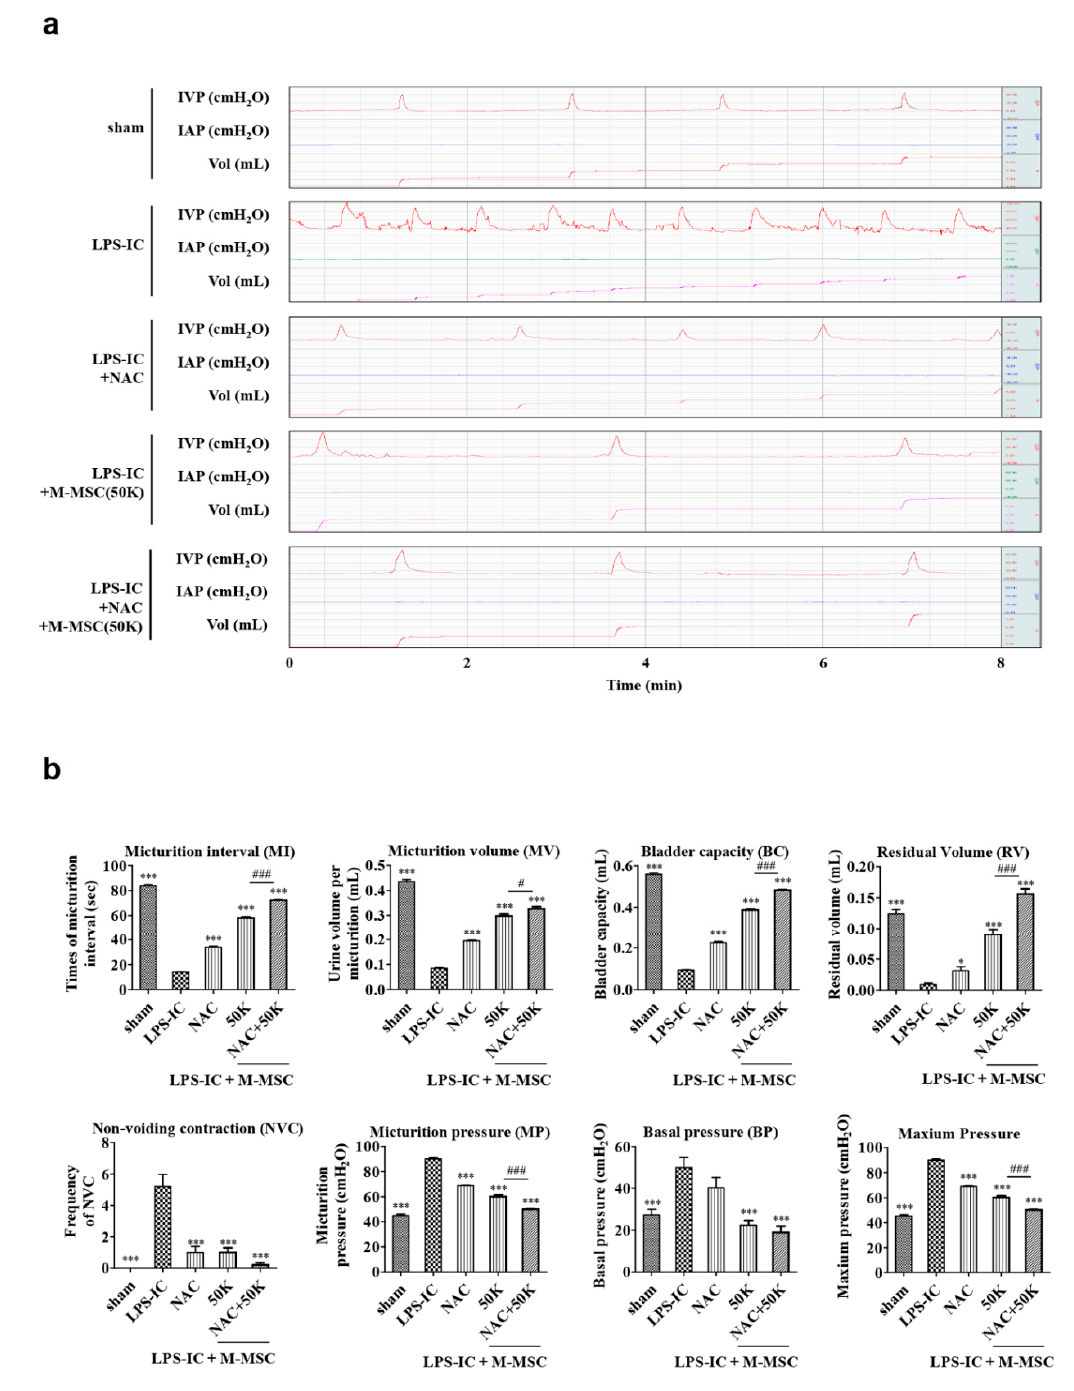
Figure 2. N-acetylcysteine (NAC) and 50K M-MSCs injection ameliorated the bladder voiding function in a LPS-IC rat. ( a ) Awake cystometry. ( b ) Representative awake cystometry results and quantitative bladder voiding parameters at one week after NAC and M-MSCs (50K, K = thousand) injection. The data are presented as the mean ± standard error of the mean (from five independent animals in each group). * p < 0.05, ** p < 0.01, *** p < 0.001 compared with the LPS group using the Bonferroni post-test. IVP: intravesical pressure; IAP: intra-abdominal pressure; sham, sham operated.